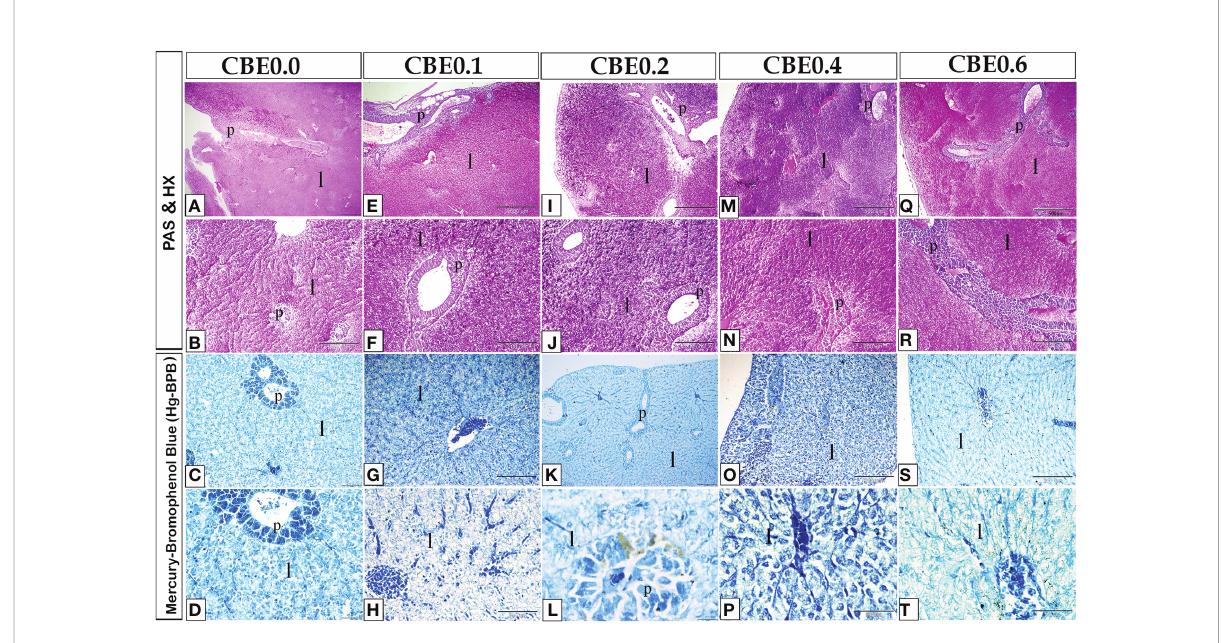
FIGURE 9 Paraf fi n sections of liver stained with PAS-HX (photos A, B, E, F, I, J, M, N, Q, R ) for glycogen or carbohydrate content staining and MercuryBromophenol (photos C, D, G, H, K, L, O, P, S, T ) for protein staining. The treatment groups showed an increase in glycogen or carbohydratecontent staining and Mercury Bromophenol blue protein staining when compared to the control group.